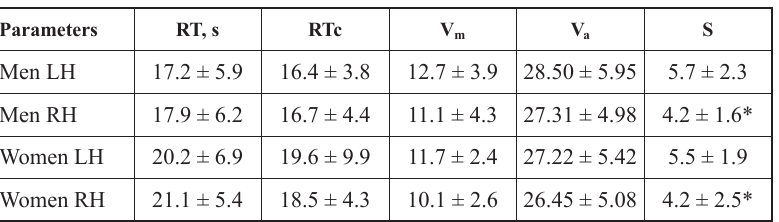
Table. Intraindividual coef fi cients of va- riance of male and female right and left hand registered